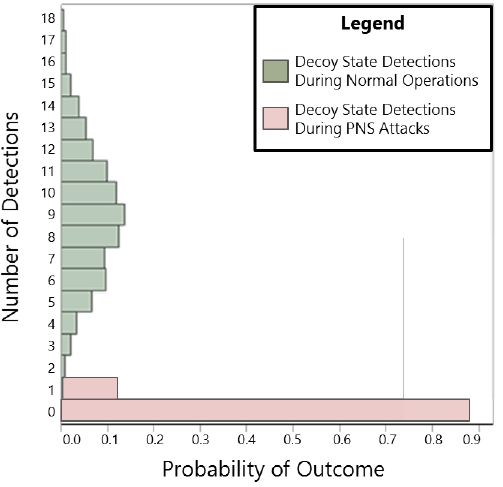
Figure 7. Simulation results detailing the number of decoy state detections per round of quantum exchange for the optimized decoy state protocol based on the fielded QKD system parameters shown in Table 6.